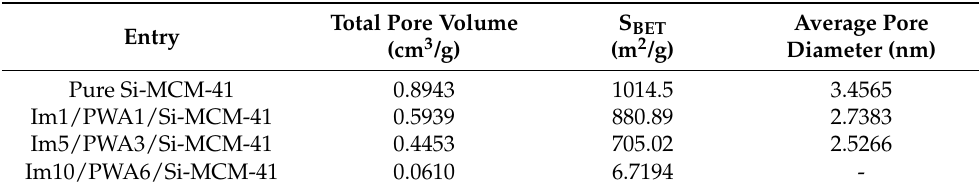
Table 1. Surface analysis of Im(x)/PWA(y)/Si-MCM-41.